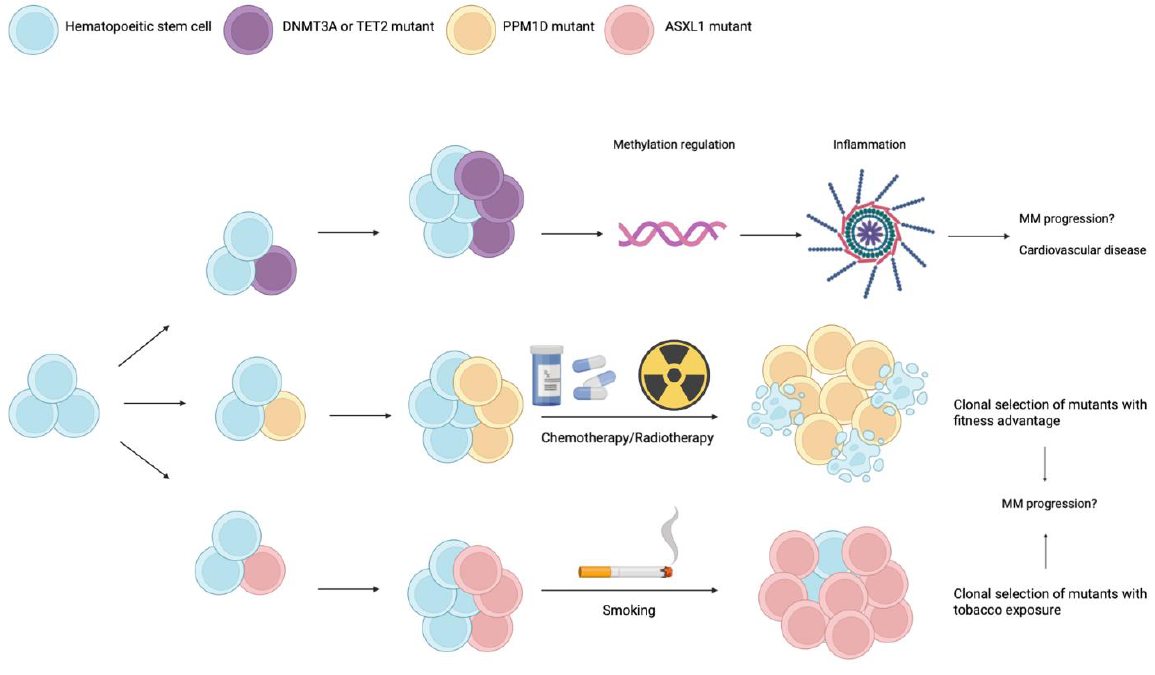
Figure 1. Schematic representation of the different mutations involved in CHIP.